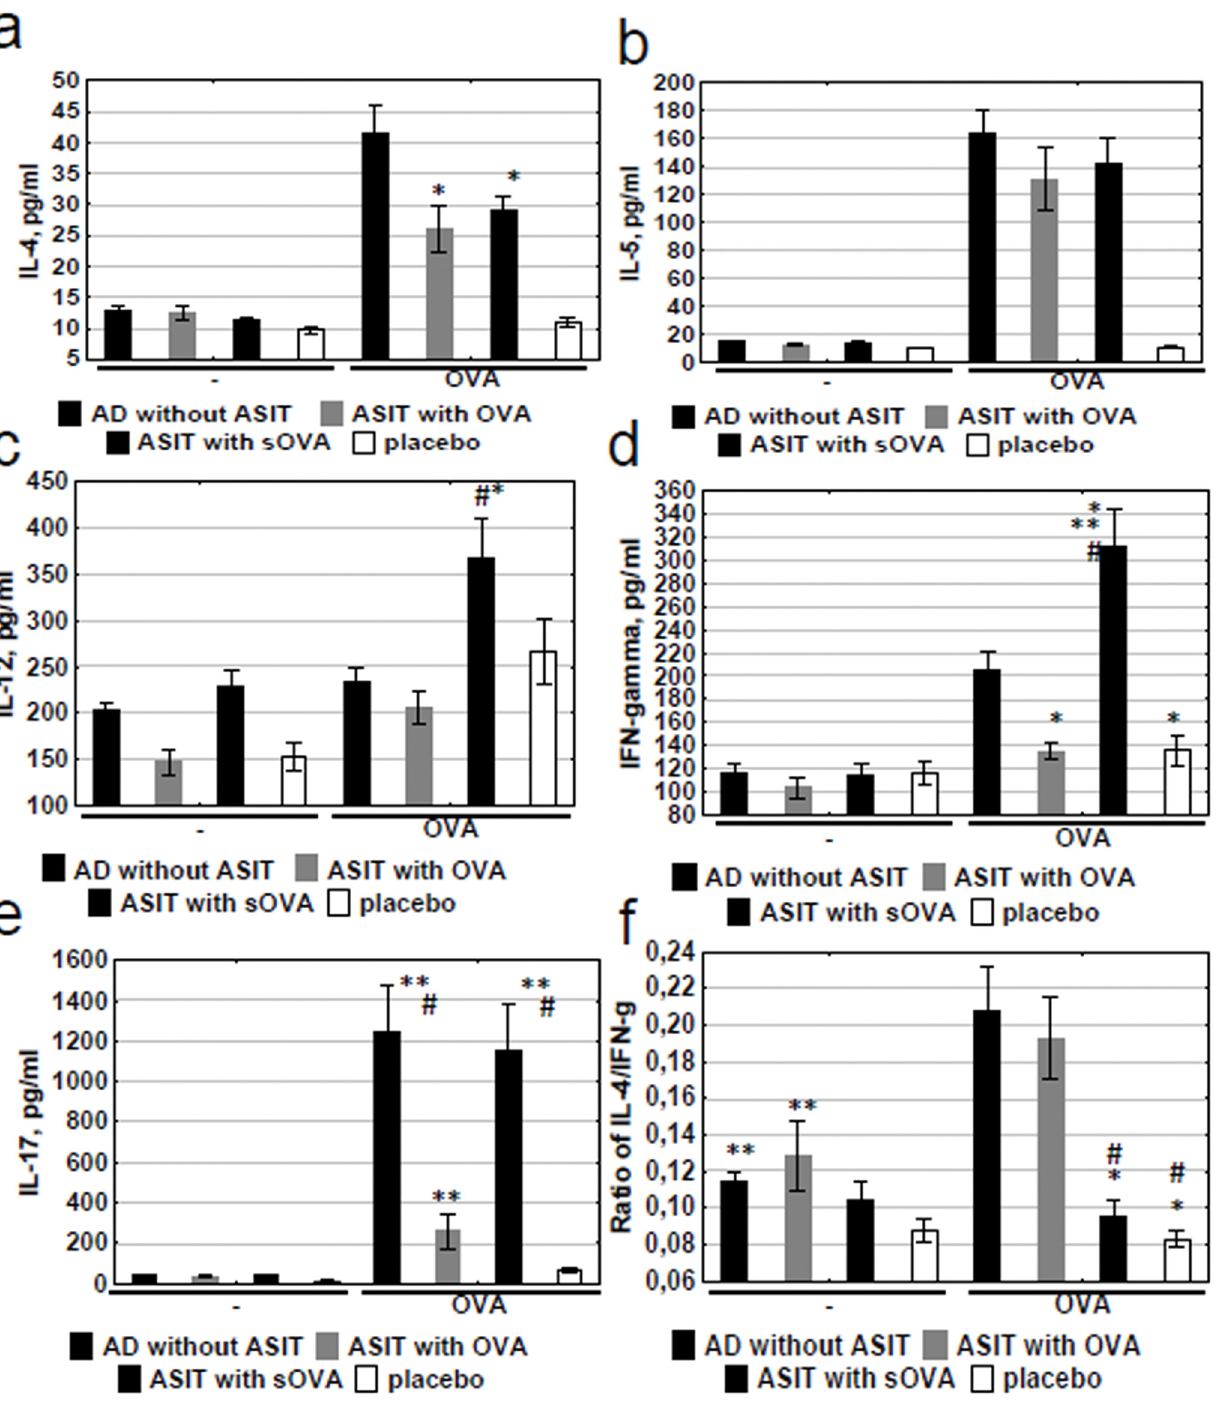
Fig 4. Levels of cytokines. The levels of cytokines in supernatants of OVA-stimulated mice splenocytes (incubated with OVA for 72hrs) were quantified by ELISA. The results are presented as mean IL concentration (mean ± SE, n = 8 for each). AD without ASIT: OVA-sensitized untreated mice; ASIT with OVA: OVA-sensitized mice treated by ASIT with OVA; ASIT with sOVA: OVA-sensitized mice treated by ASIT with sOVA; placebo: PBS-sensitized mice. Level of (a) the IL-4, (b) IL-5, (c) IL-12, (d) IFN- γ , and (e) IL-17; (f) IL-4/IFN- γ ratio in mice with ASIT. * , p < 0.05 versus “ AD without ASIT ” ; ** , p < 0.05 versus “ placebo ” ; #, p < 0.05 versus “ ASIT with OVA ”